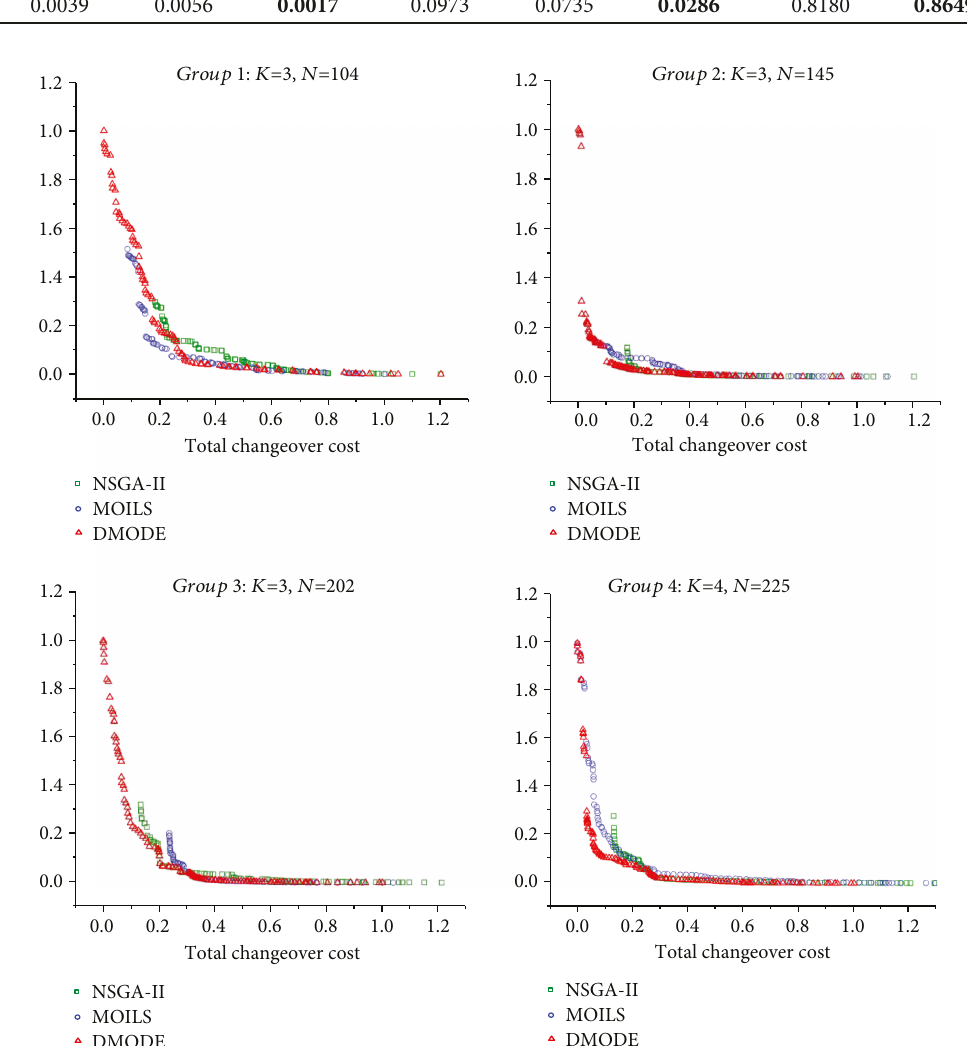
Figure 13: Evolution process IGD metric obtained by NSGA-II, MOILS, and